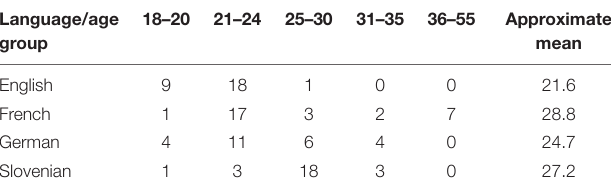
TABLE 3 | Experiment 1: Participation by age group and